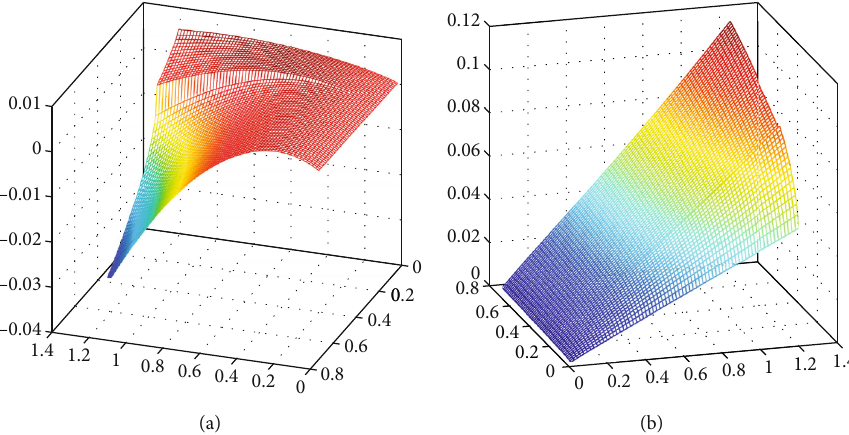
Figure 3: The solution ϑ = ð ϑ The norm k ϑ k = 3 : 8669 .